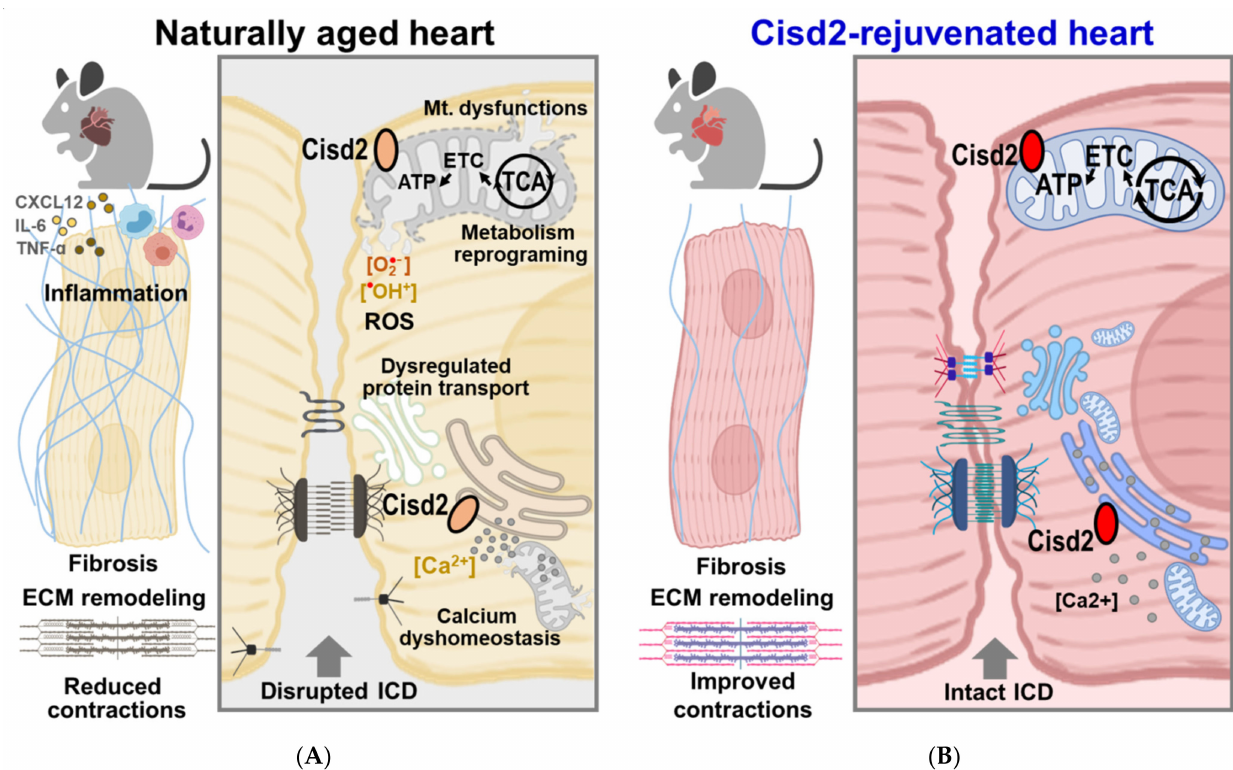
Figure 6. Cardiac-specific overexpression of Cisd2 at the late-life stage rejuvenates the aging heart. ( A ) In the WT mice at an old age, a decrease in cardiac Cisd2 results in mitochondrial dysfunction and metabolic reprogramming, as well as in the increase in ROS production, dysregulated proteostasis, and disrupted cytosolic Ca 2+ homeostasis. Consequently, these defects lead to cellular damage to cardiomyocytes, as well as degeneration of the ICDs, an increase in interstitial fibrosis, and remodeling of the extracellular matrix together with dysregulation of cardiac electromechanical functions. As a result, these functional and structural alterations, which are accompanied by chronic inflammation, bring about cardiac aging. ( B ) In the Cisd2 icOE mice at an old age, cardiac-specific overexpression of Cisd2 at the late-life stage appears to rejuvenate the aging heart by reversing the age-related structural damage and the functional decline of the heart. ECM, extracellular matrix; ETC, electron transport chain; ICD, intercalated disc; Mt., mitochondrial; TCA, tricarboxylic acid cycle. The figure was created with